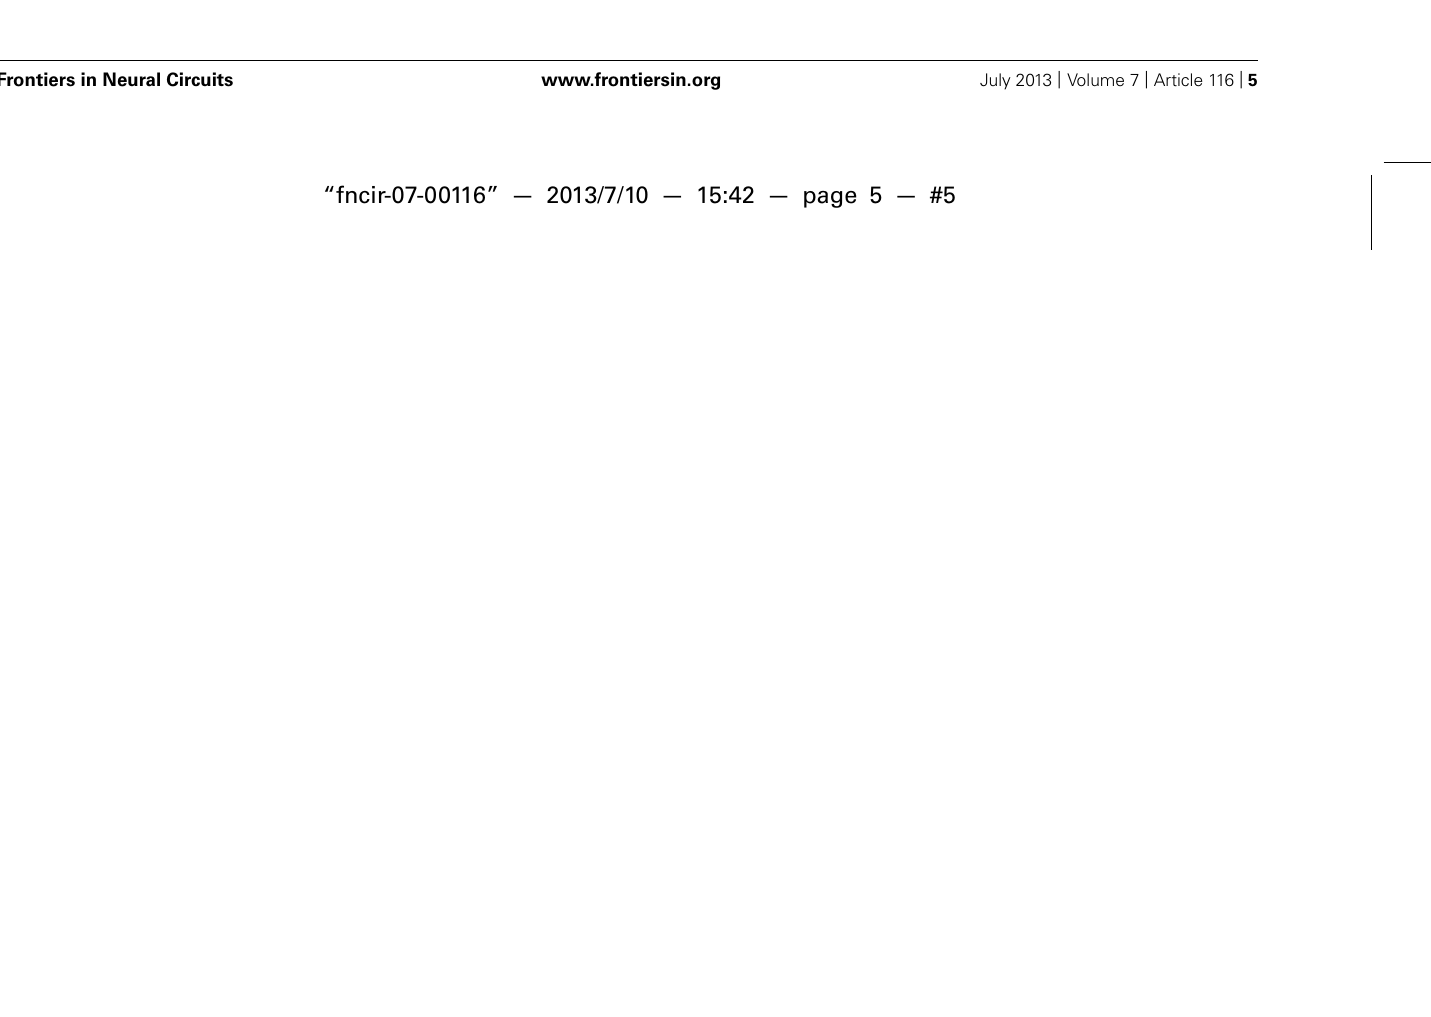
FIGURE 4 | Giant synaptic potentials are associated with increased conductance. (A) Voltage traces at 4 different membrane potentials resulting from DC current injection of − 100, 0, 200, and 300 pA in blue, green, black, and cyan, respectively. Spikes have been truncated for illustration purposes. (B) Averaged of several hundreds of GSPs from the same membrane potentials shown in (A) . (C) I/V curves for resting potential (solid lines) and peak of the GSP (dashed lines). Blue lines denote I/V curves calculated from the average GSP method.The R in values that were obtained using this method were 52 and 23 M (cid:2) for resting potential and GSP peak, respectively.